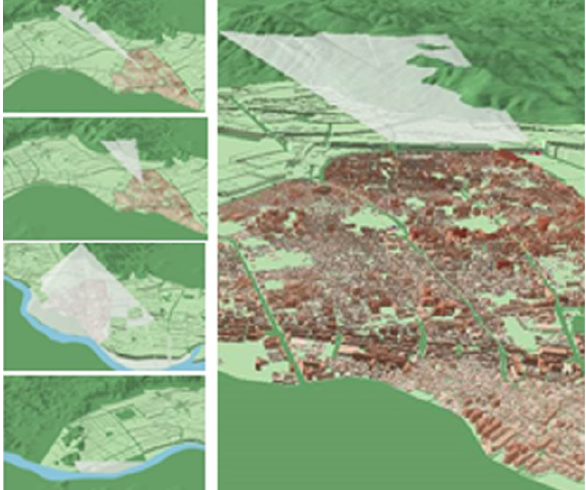
Figure 9. Corridors Calculation process of overlaying current development conditions and existing regulatory plans (Wang Tong, Jiang Ying, Luo Wen, 2016)